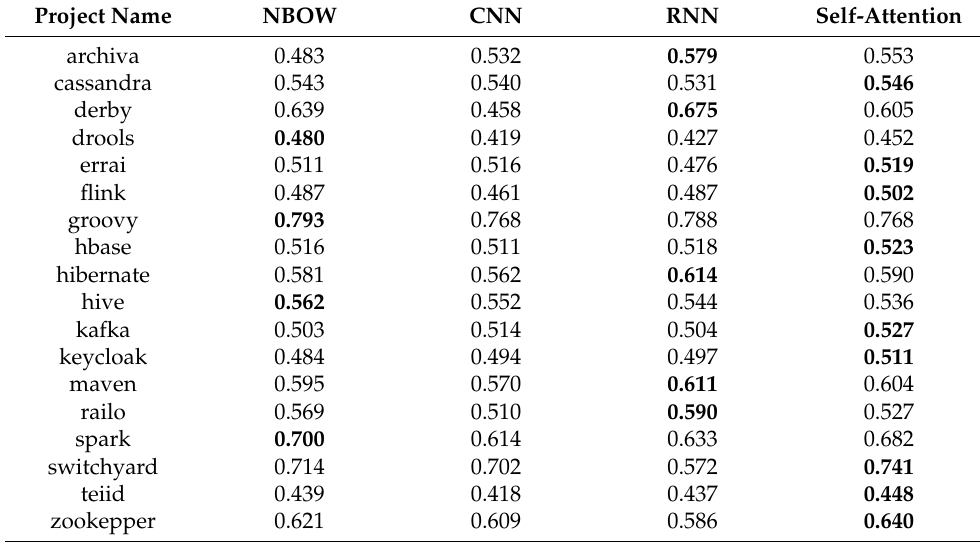
Table 5. Performance of 4 neural network models under Recall